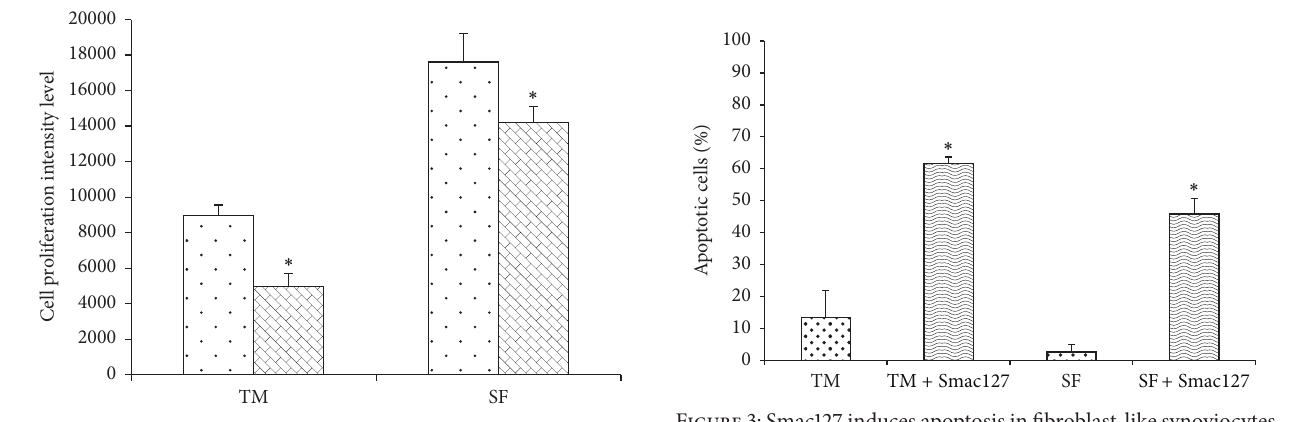
Figure 3: Smac127 induces apoptosis in fibroblast-like synoviocytes (FLSs) derived from patients with rheumatoid arthritis (RA). RA- FLSs were cultured in the presence of tissue medium alone (TM) or in synovial fluid (SF) for 5 days. Smac127 (15 𝜇 M) was added for 24 hrs. Apoptosis was detected by Annexin V test. Results are expressed as the mean percentage ± SD from five individual experiments. ∗ 𝑝 < 0.05 versus CTRL or